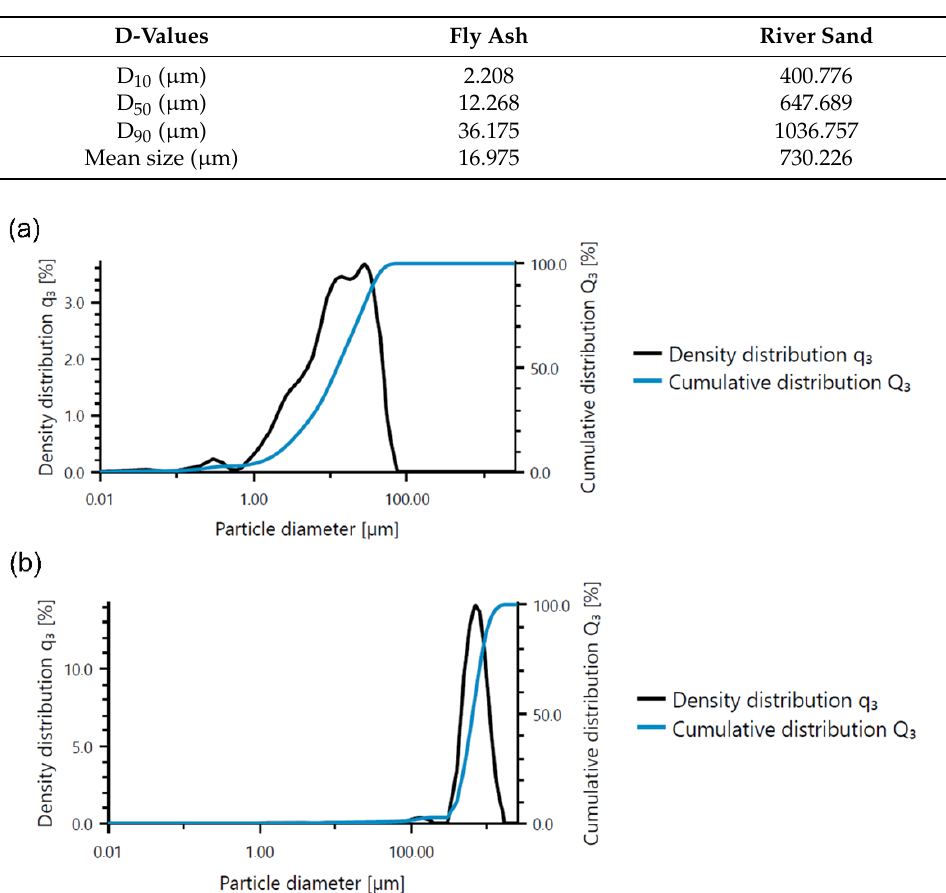
Table 5. The particle size of based materials.